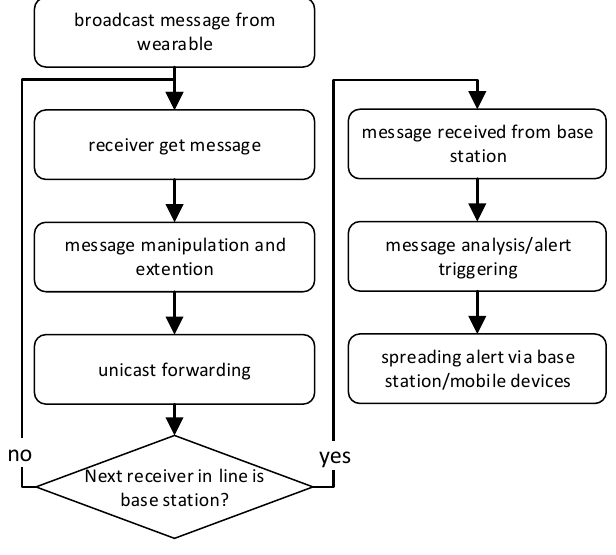
Figure 3. Flowchart of the general INBED system